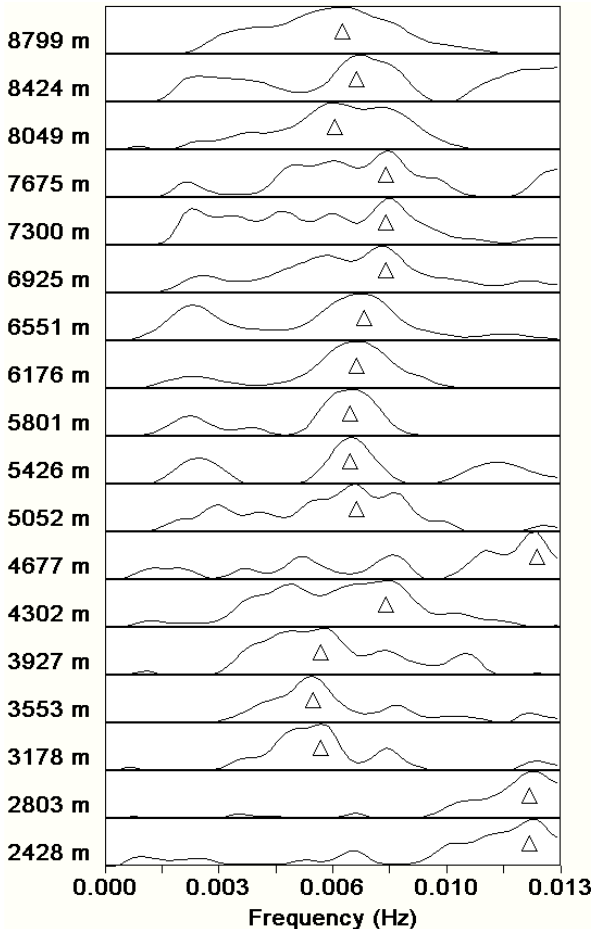
Fig. 10. Vertical wind spectra obtained with the VHF radar on 22 February 2002 between 12:17 and 12:31UTC (45s resolution pro- files with zero-padding up to 128 spectral points). Peaks are men- tioned by triangles.